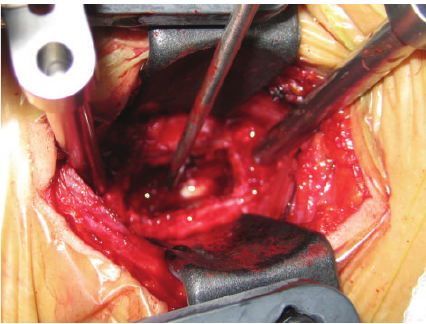
Figure 3: Intraoperative photo showing surgical debridement and drainage of the epidural abscess through an anterior cervical approach.